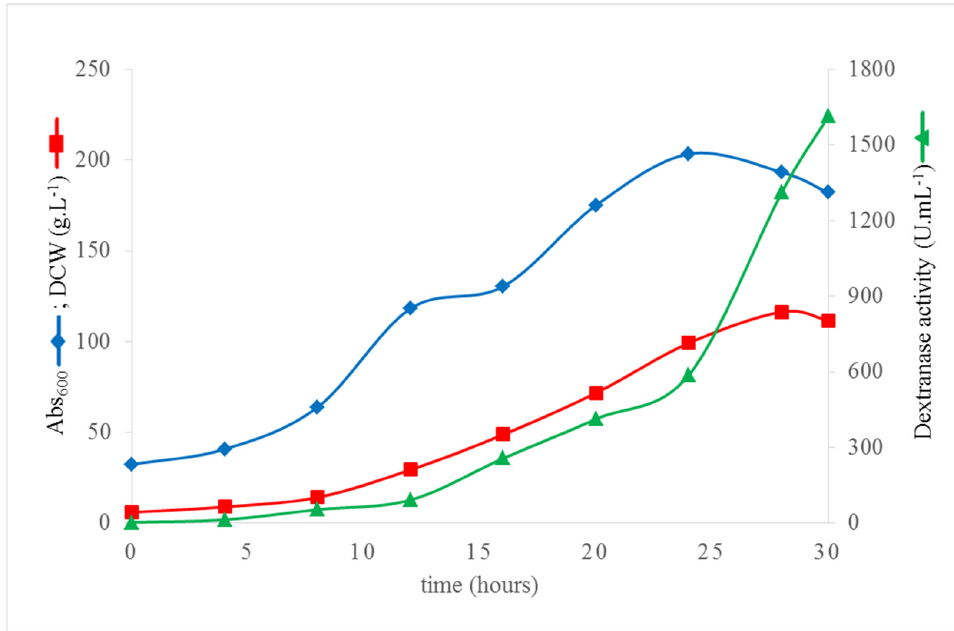
Figure 5. Cell growth and dextranase enzyme production of K. phaffii DEX49A– Δ SP– Δ N30 in a fed-batch culture. Abs 600 , DCW values in g·L − 1 and dextranase activity (U·mL − 1 ) from the study in a 5 L fermenter using FM21–PTM1 medium.